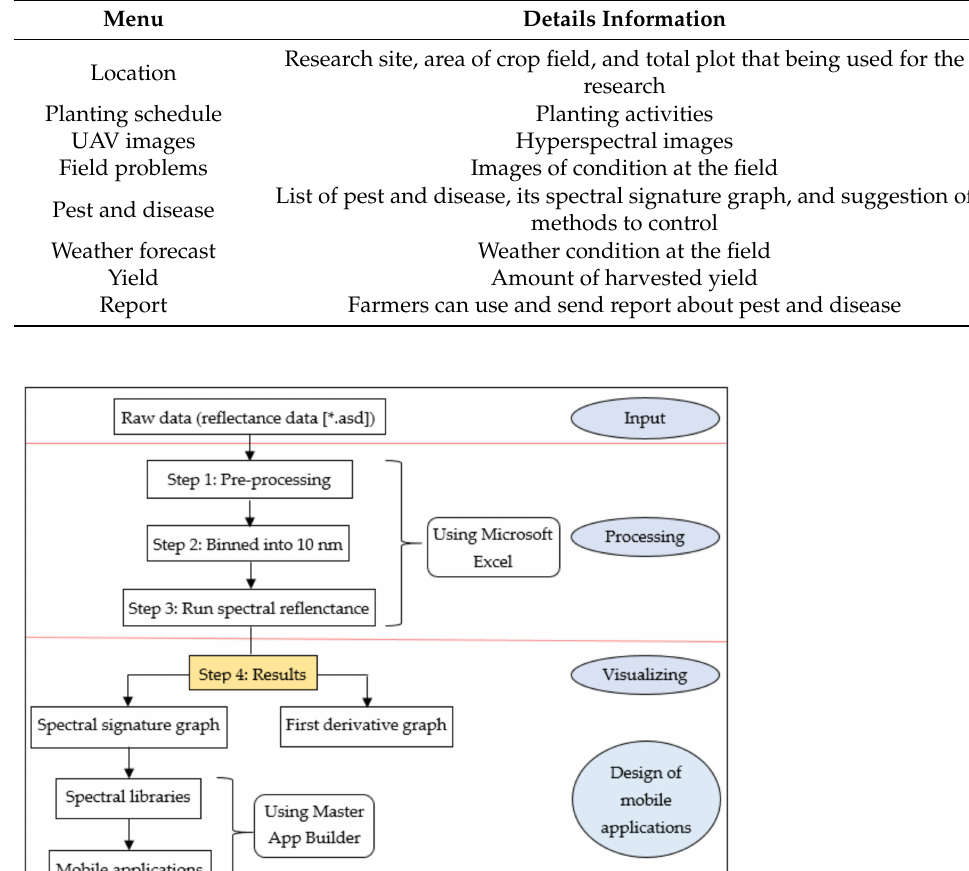
Table 4. List of main menus of the mobile applications.